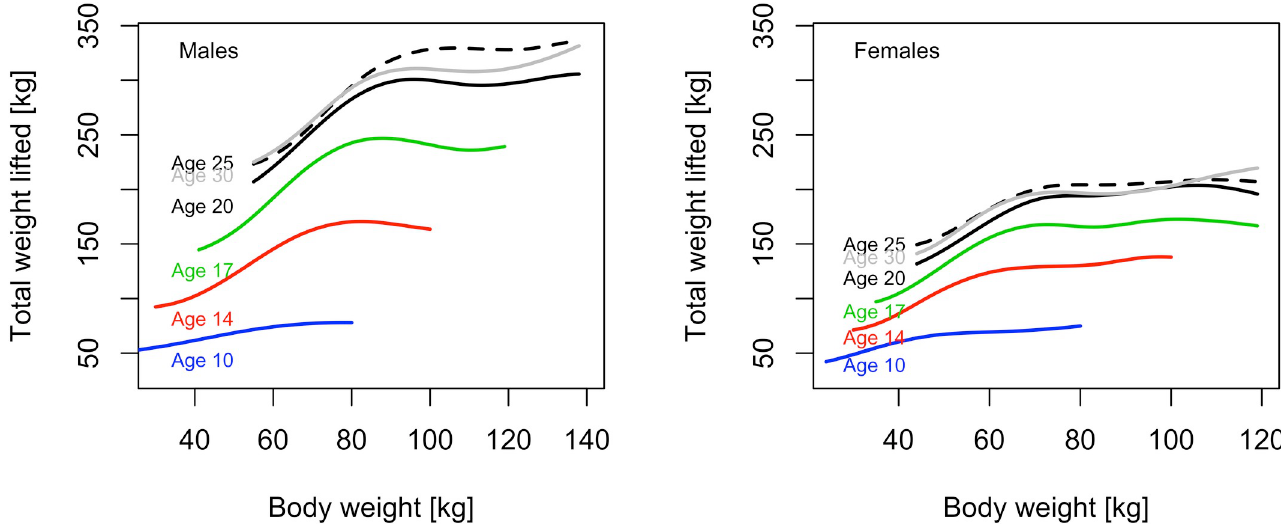
Fig 4. Male and female performance for different ages across